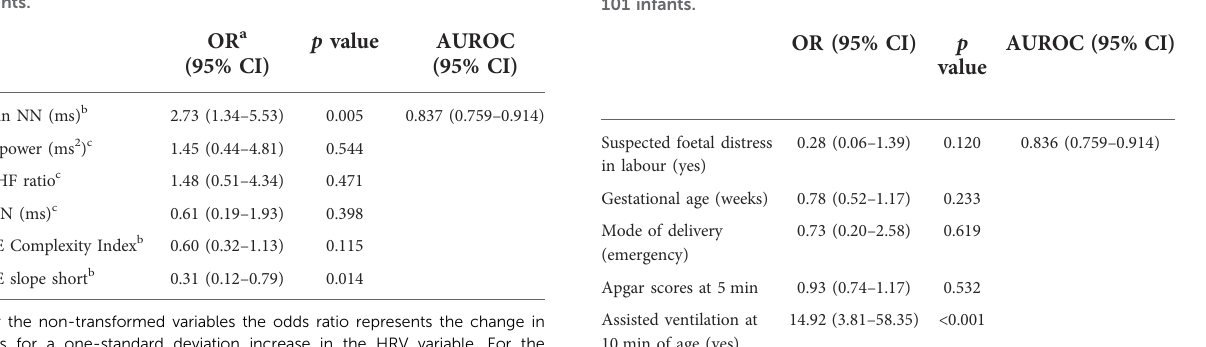
TABLE 4 HRV multivariable analysis (HRV prediction model), n =101